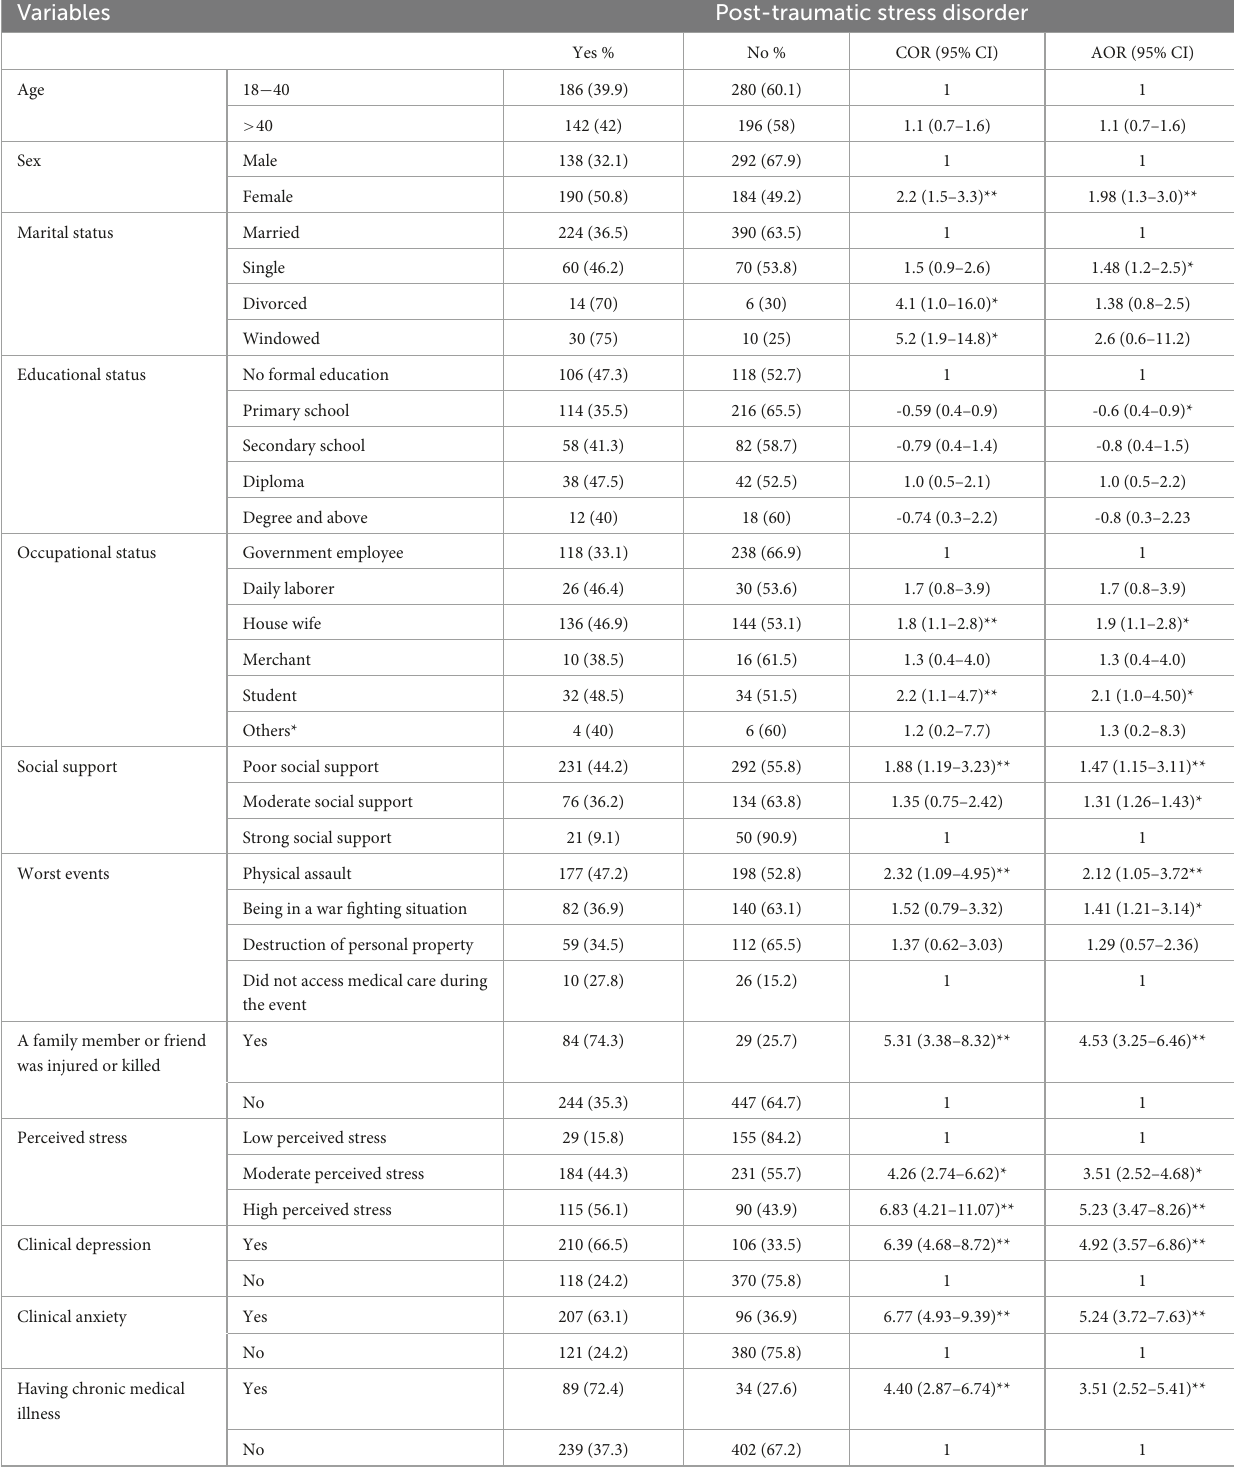
TABLE 3 Factors associated with post-traumatic stress disorder (PTSD) among the respondents at war affected area of Nefas Meewcha town, Northwest Ethiopia, 2022 ( n =